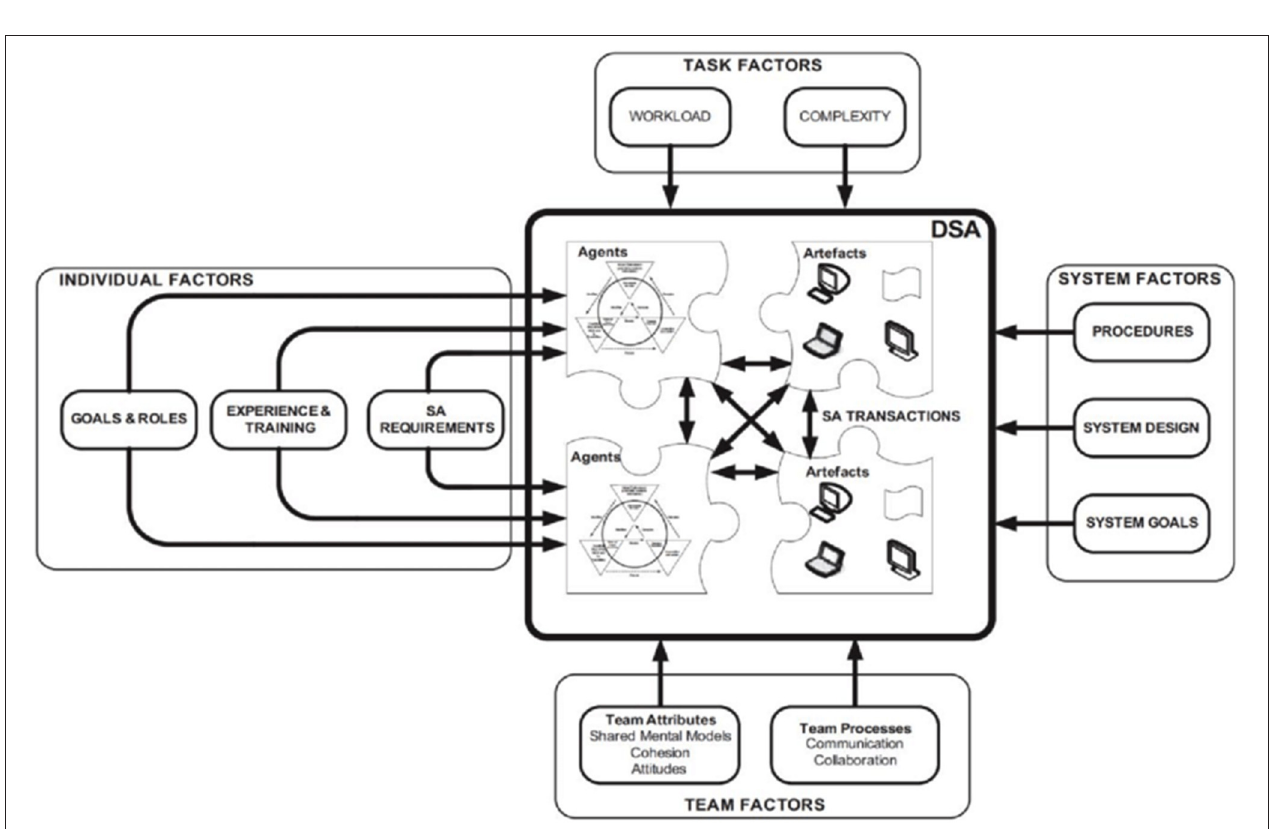
FIGURE 4 | Illustration of distributed situational awareness (Salmon et al., 2009).